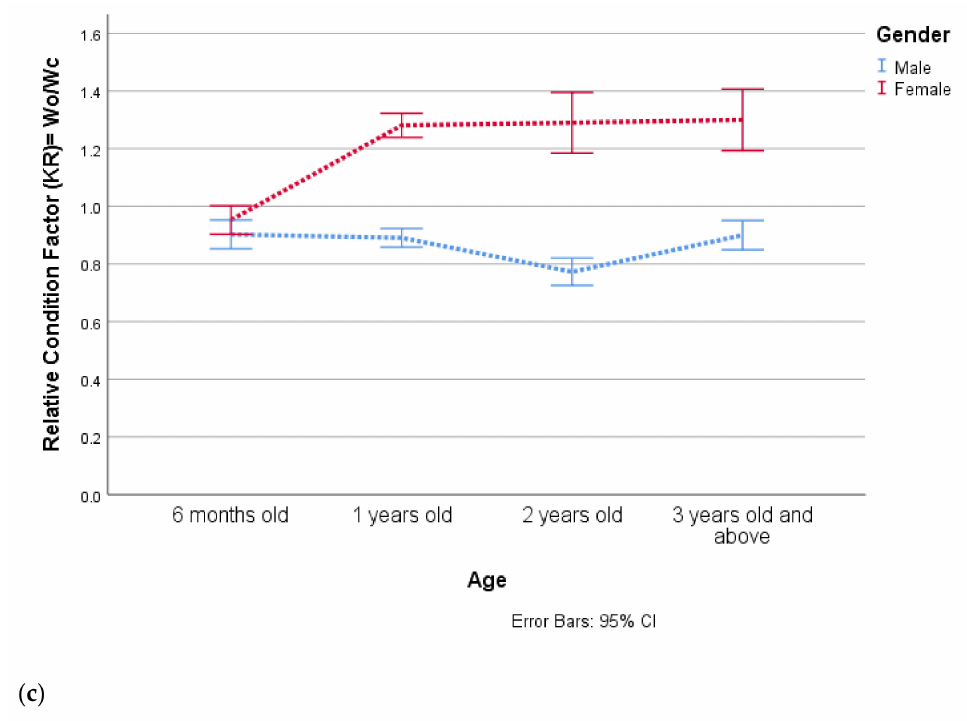
Figure 3. Age-wise ( a ) calculated weight and condition factors; ( b ) Fultion condition factor and ( c ) relative condition factor of Chinese